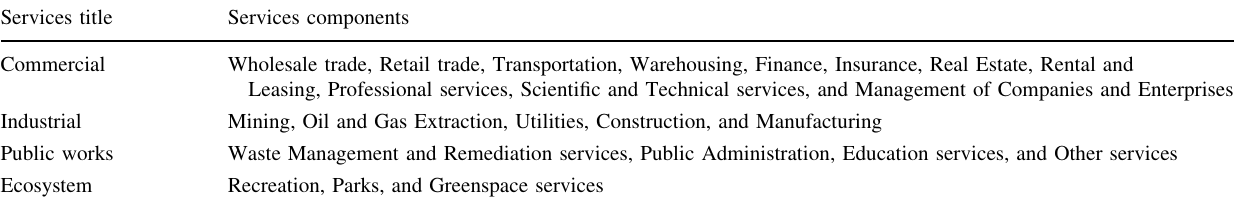
Table 3 Goods and services sector aggregate productive